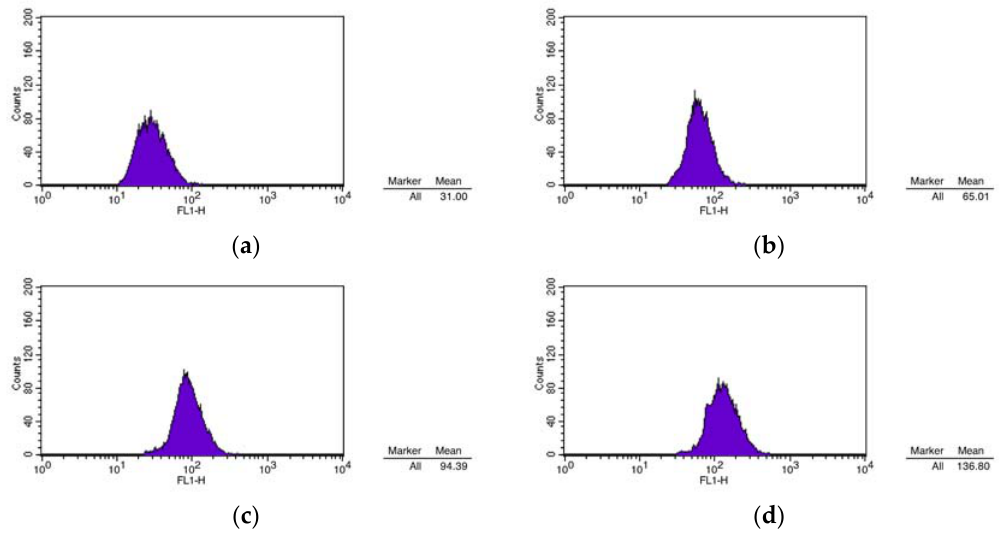
Figure 7. Effect of compound 1 on calcium in HepG2 Cells: ( a ) control group; ( b ) 1 μ M; ( c ) 3 μ M; and ( d ) 12 μ M.